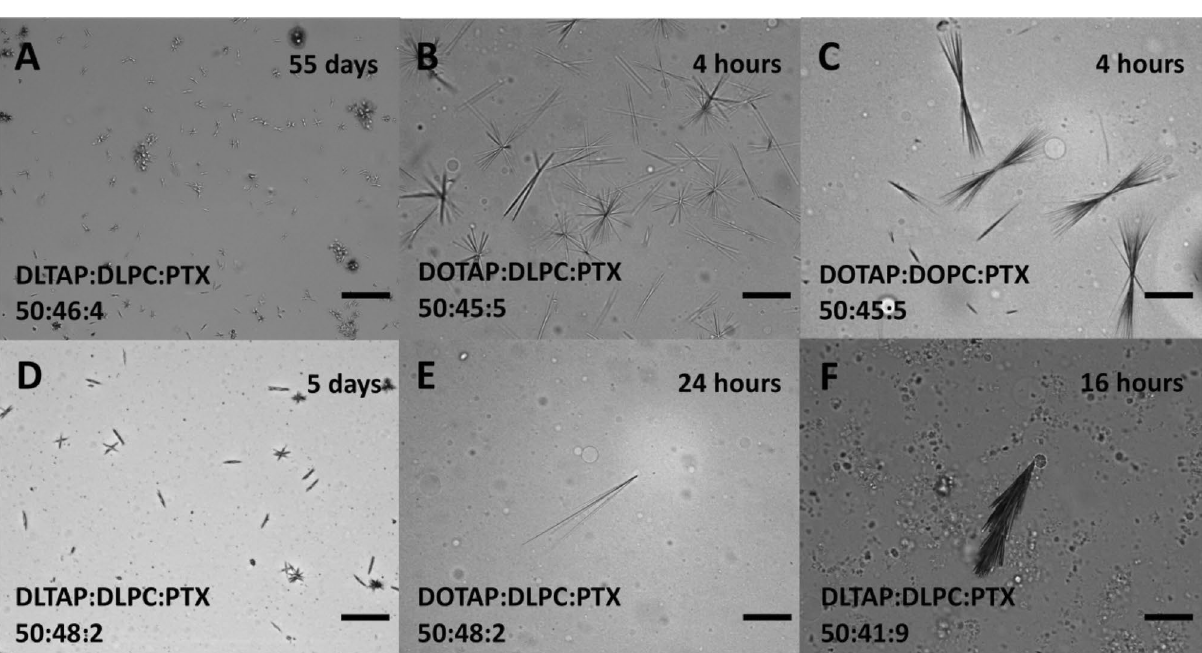
Figure 3. Selected DIC microscopy images of liposomes and phase-separated PTX, illustrating the size and shape variety of observed PTX crystals as discussed in the text. The samples were unsonicated PTX-loaded CLs of the molar compositions indicated on the images. Images were taken after hydration for the time noted. Scale bars: 50